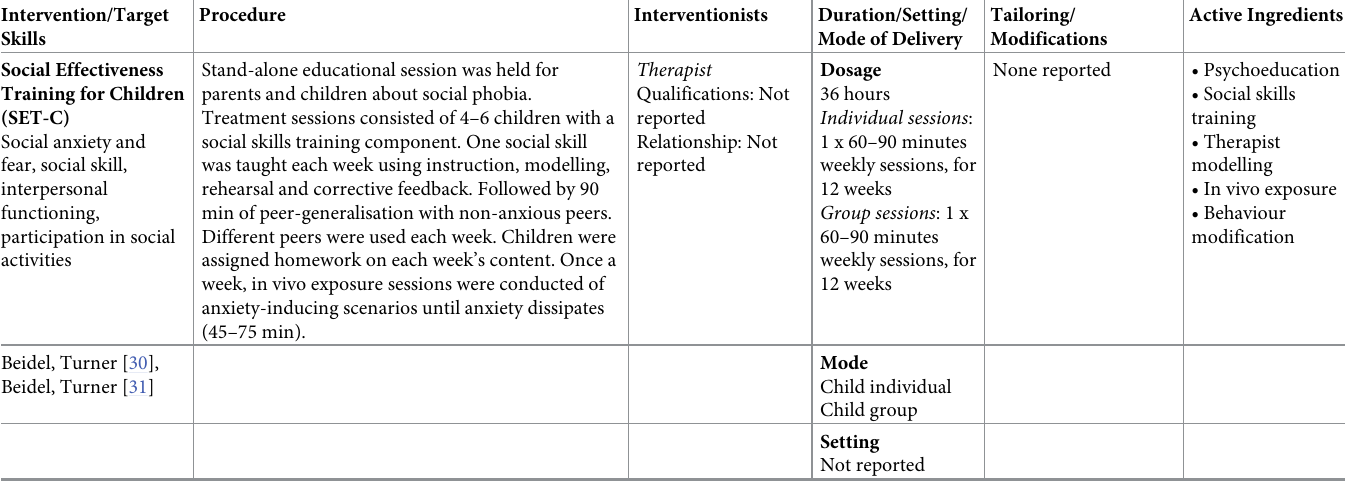
Table 3. Characteristics of